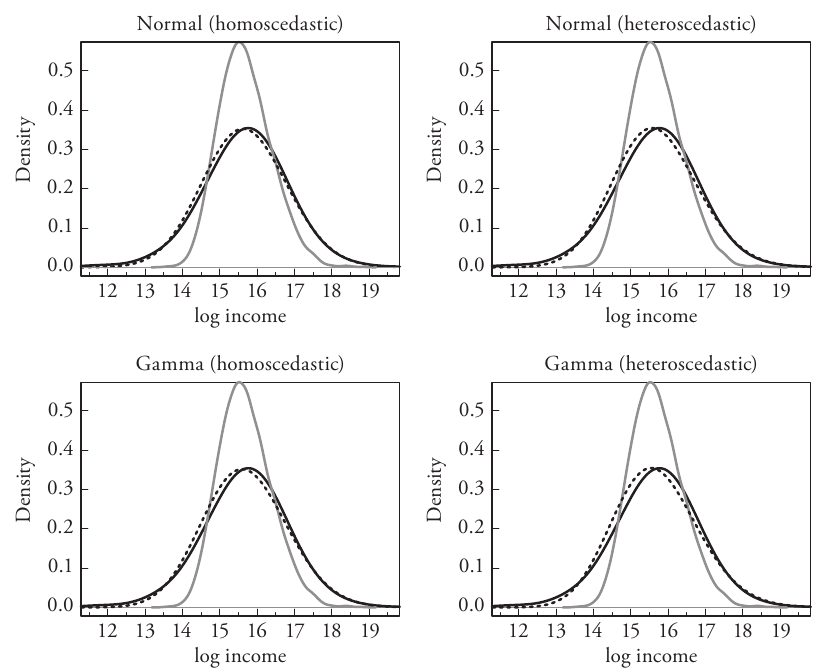
Figure 2: Density estimates using an APLM regression